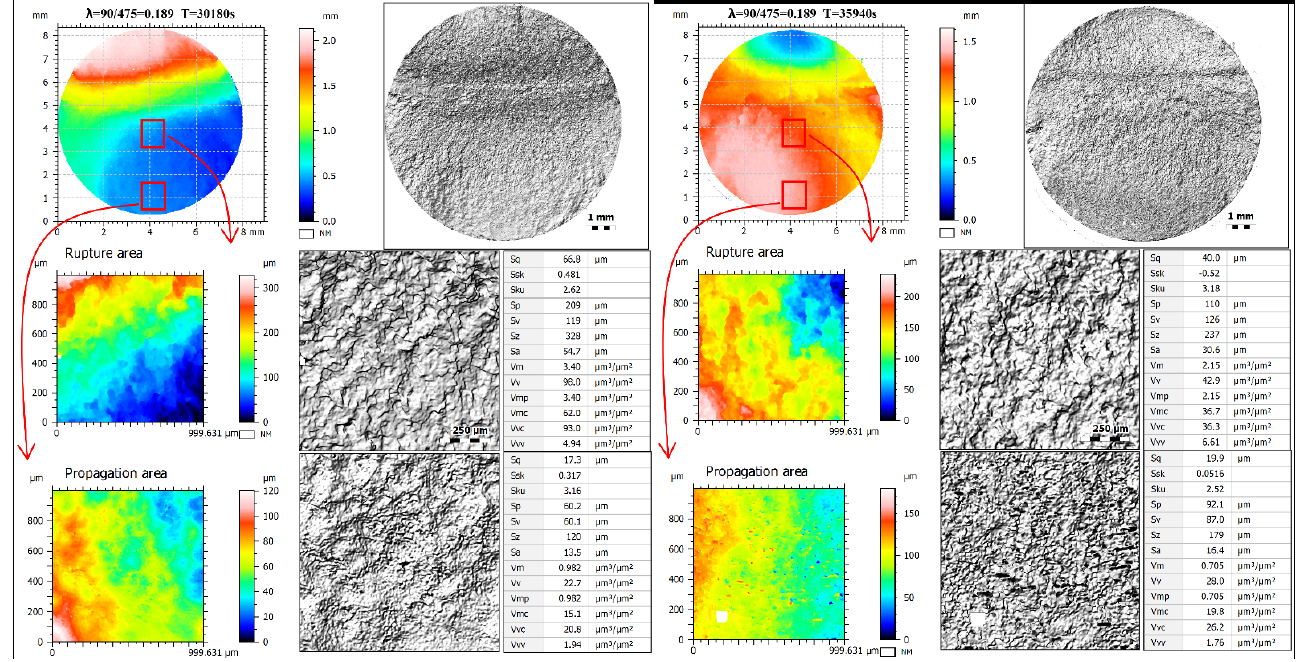
Figure 5. Graphical presentation of the functional (volume) parameters: ( a ) an exemplary surface profile; ( b ) functional (volume) parameters of Abbott–Firestone curve according to ISO